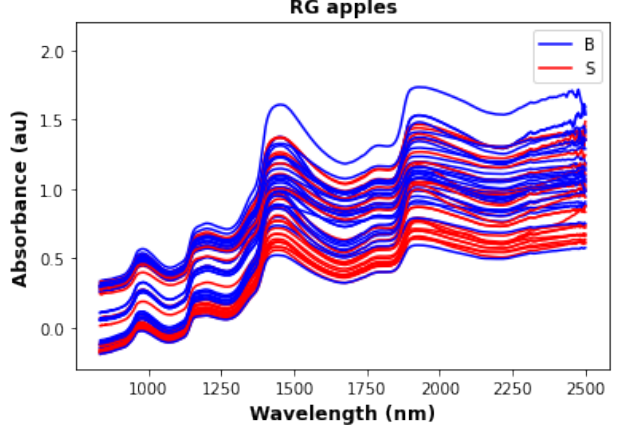
Figure 1. Infrared data for 50 randomly selected GD, GS, and RG, where B are the bad apples, and S are the good apples.